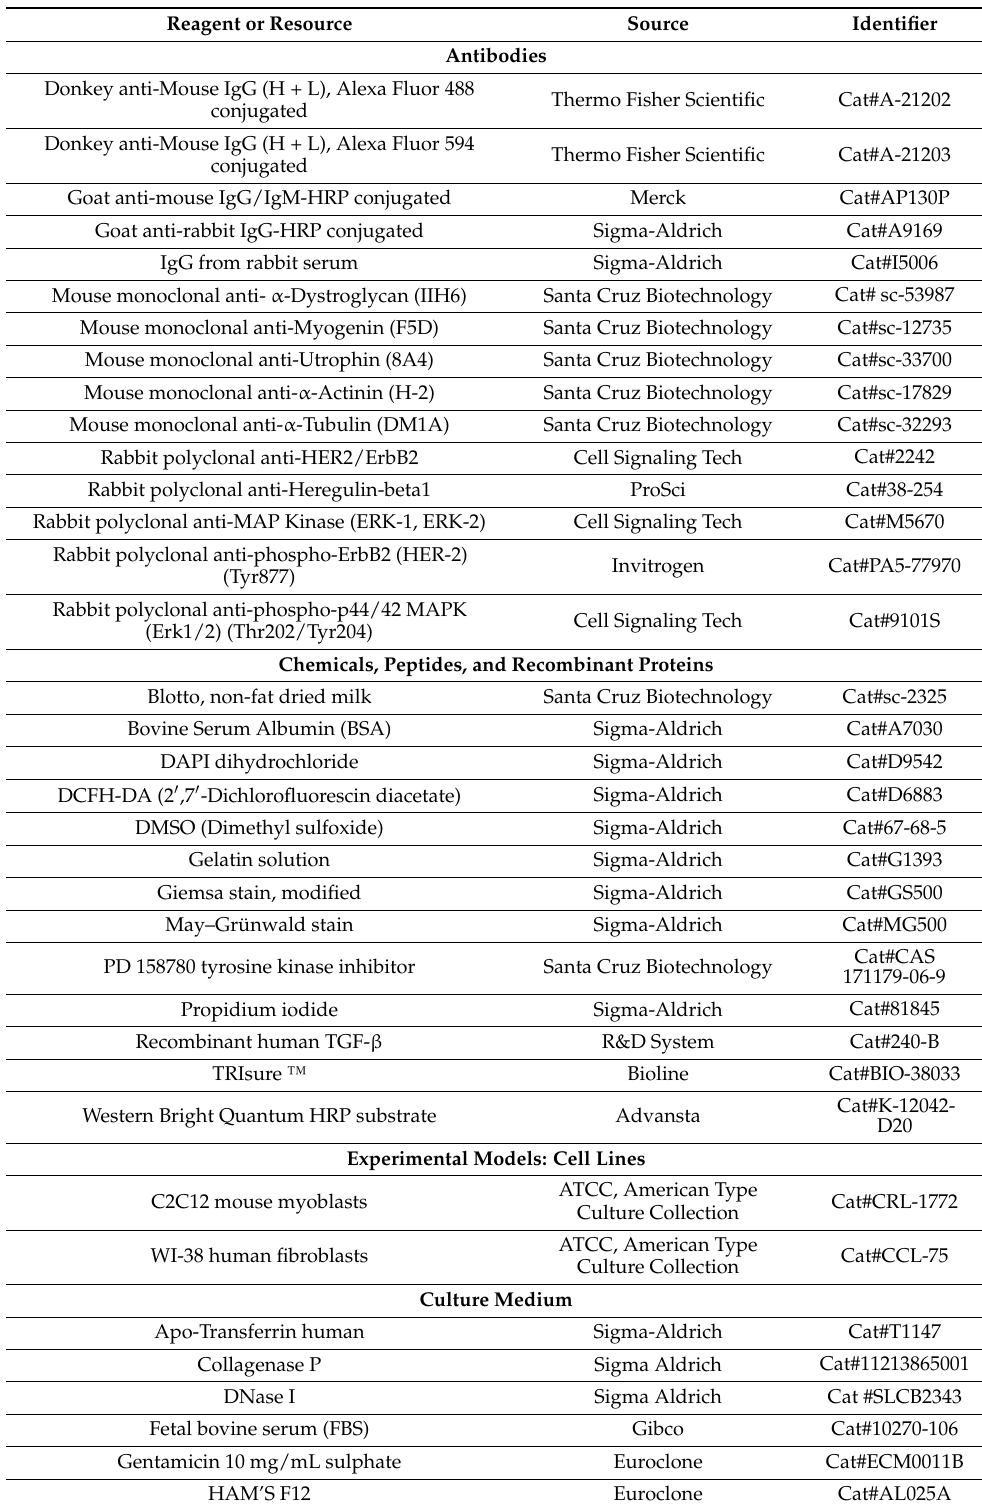
Table A1. Key resources